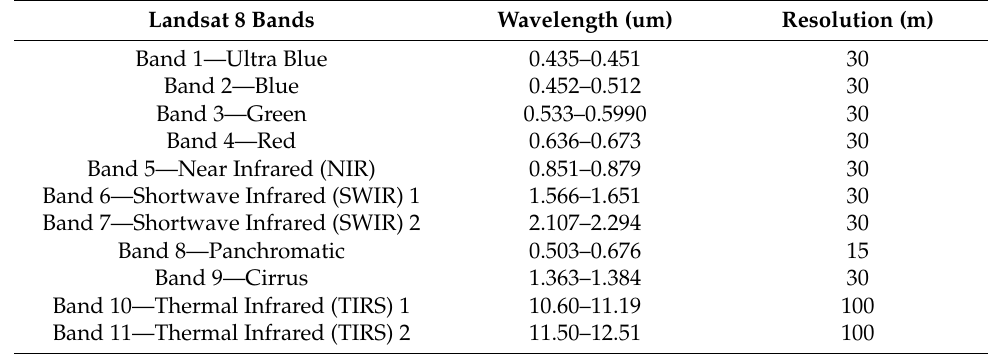
Table 1. Comparison of corresponding band properties of Landsat 8 OLI and TIRS images